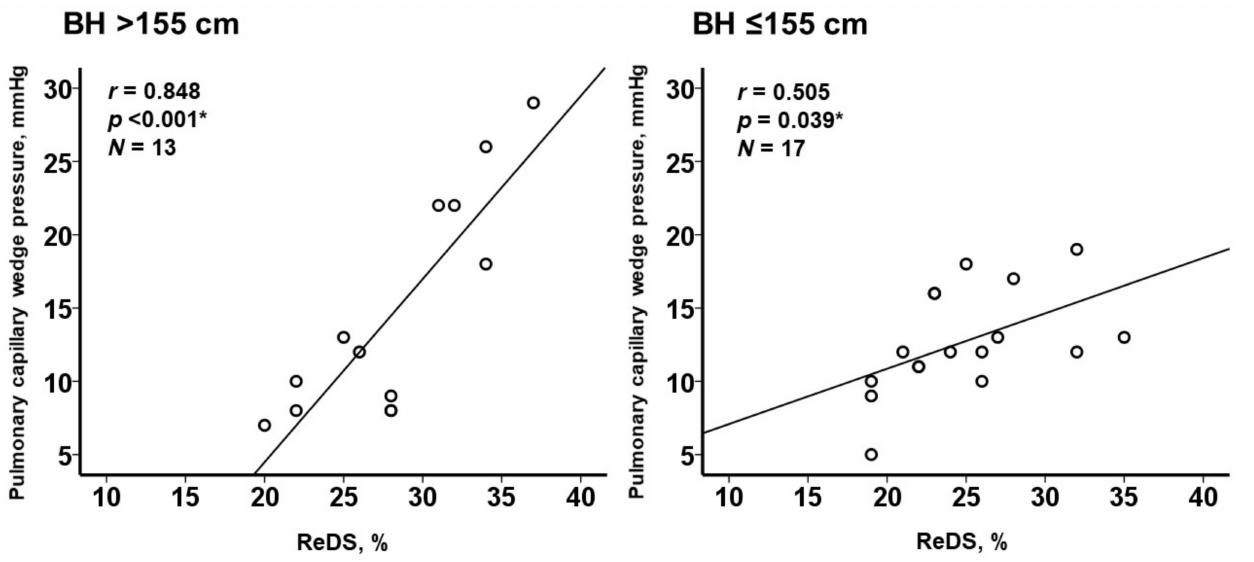
Figure 6. Correlation between ReDS value and PCWP stratified by body height. * p < 0.05 by Pearson’s correlation